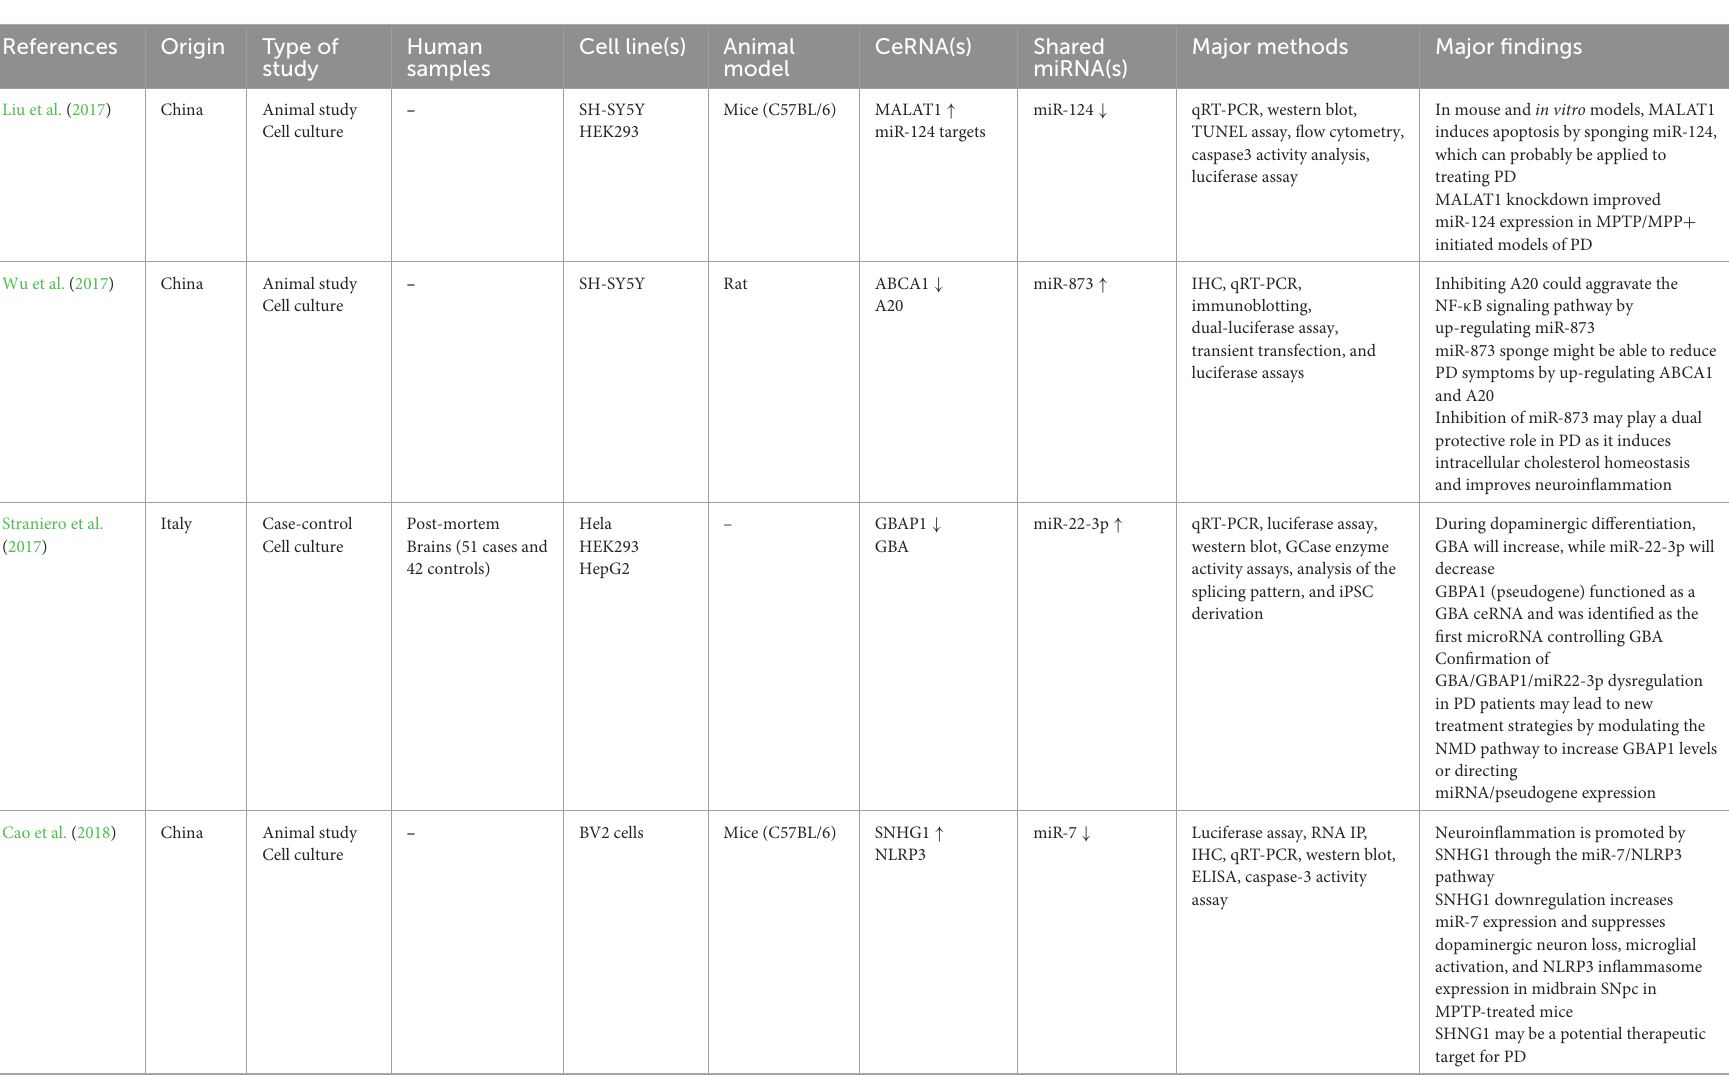
TABLE 1 CeRNAs axes studies in